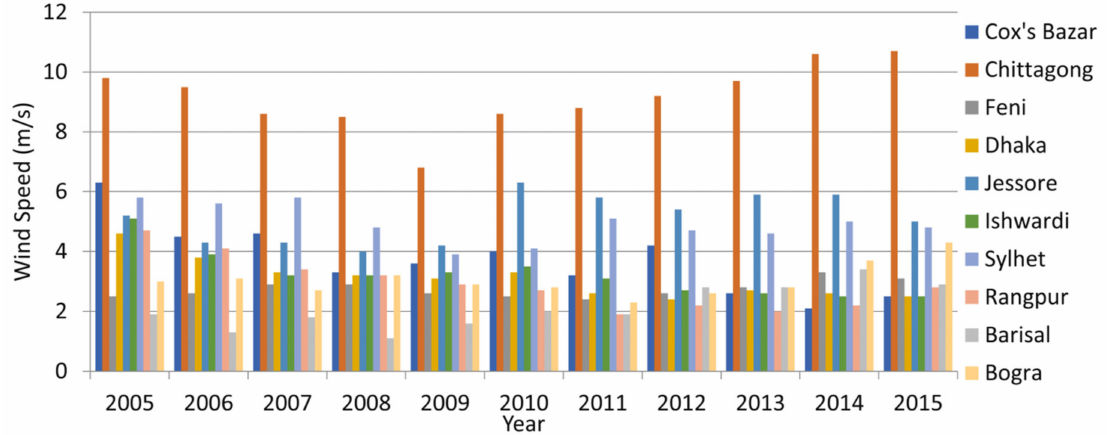
Figure 3. Wind speed in various potential districts of Bangladesh